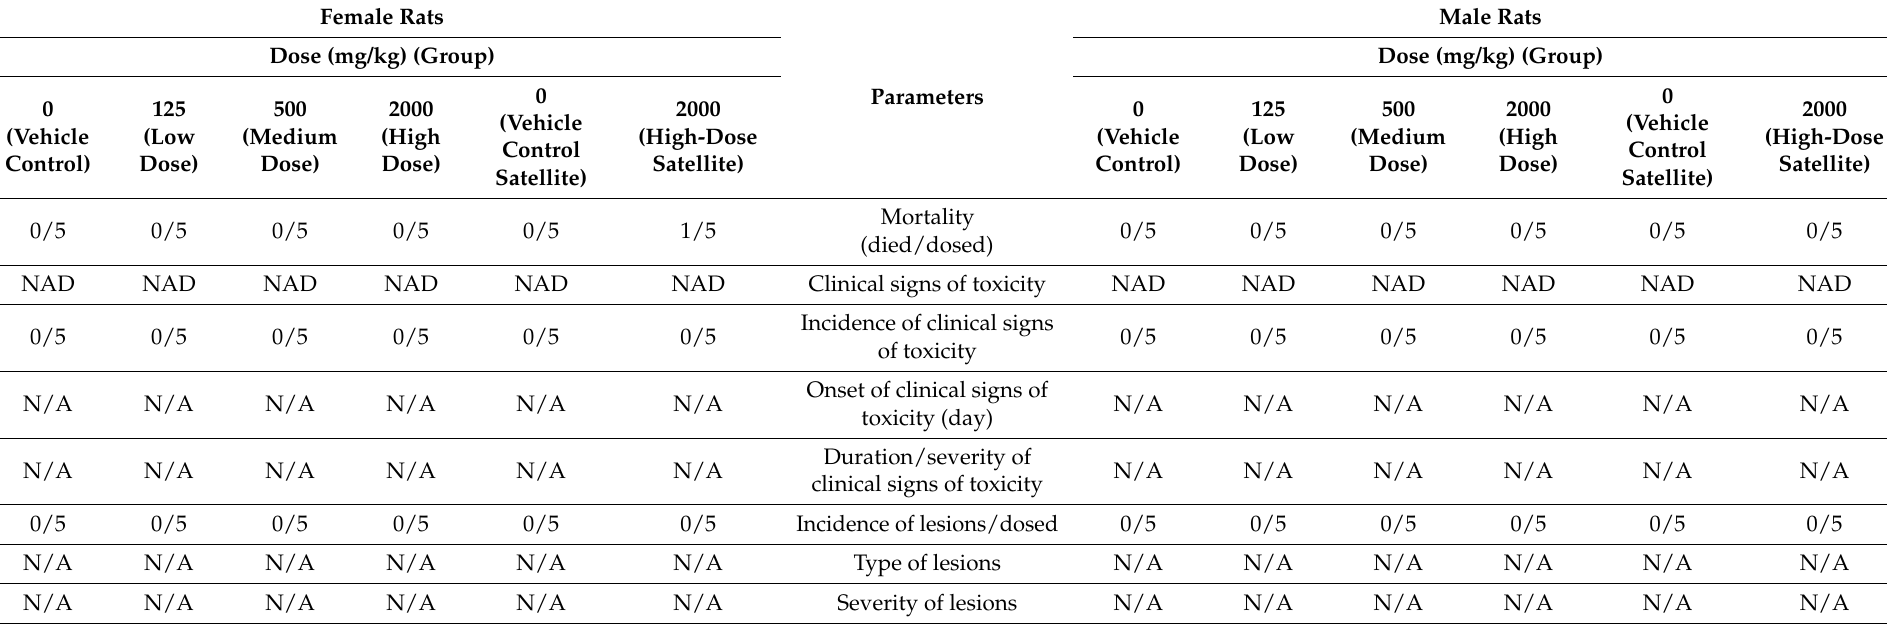
Table 1. Summary of mortality and clinical signs of toxicity in female and male